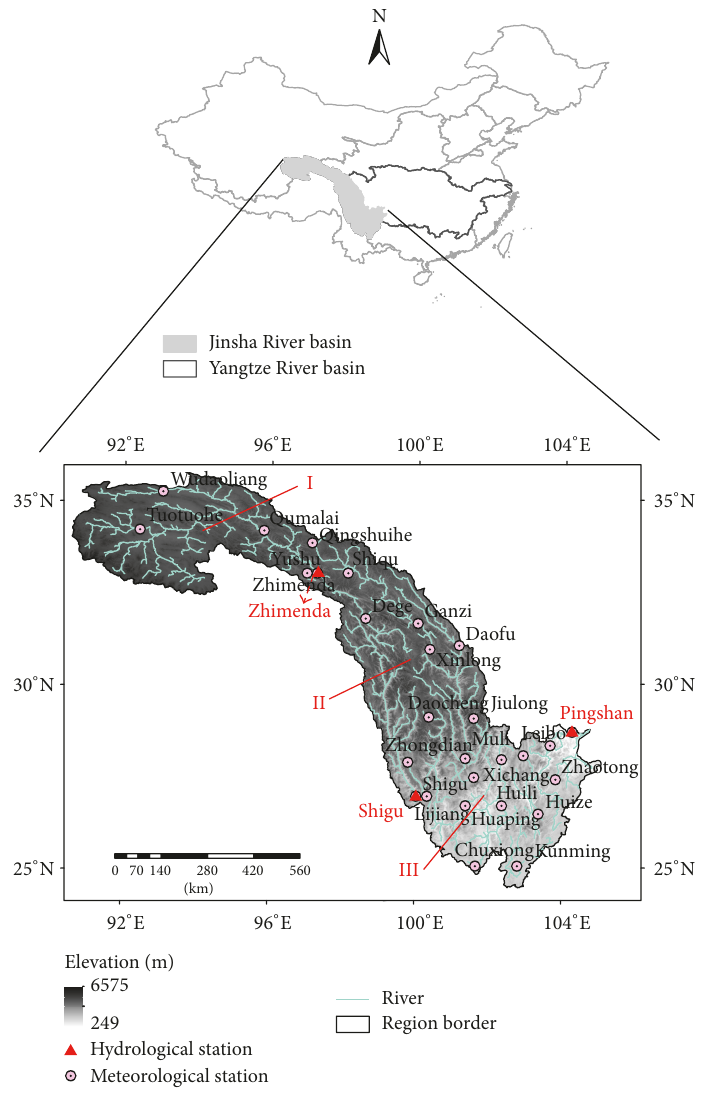
Figure 1: Map of the Jinsha River